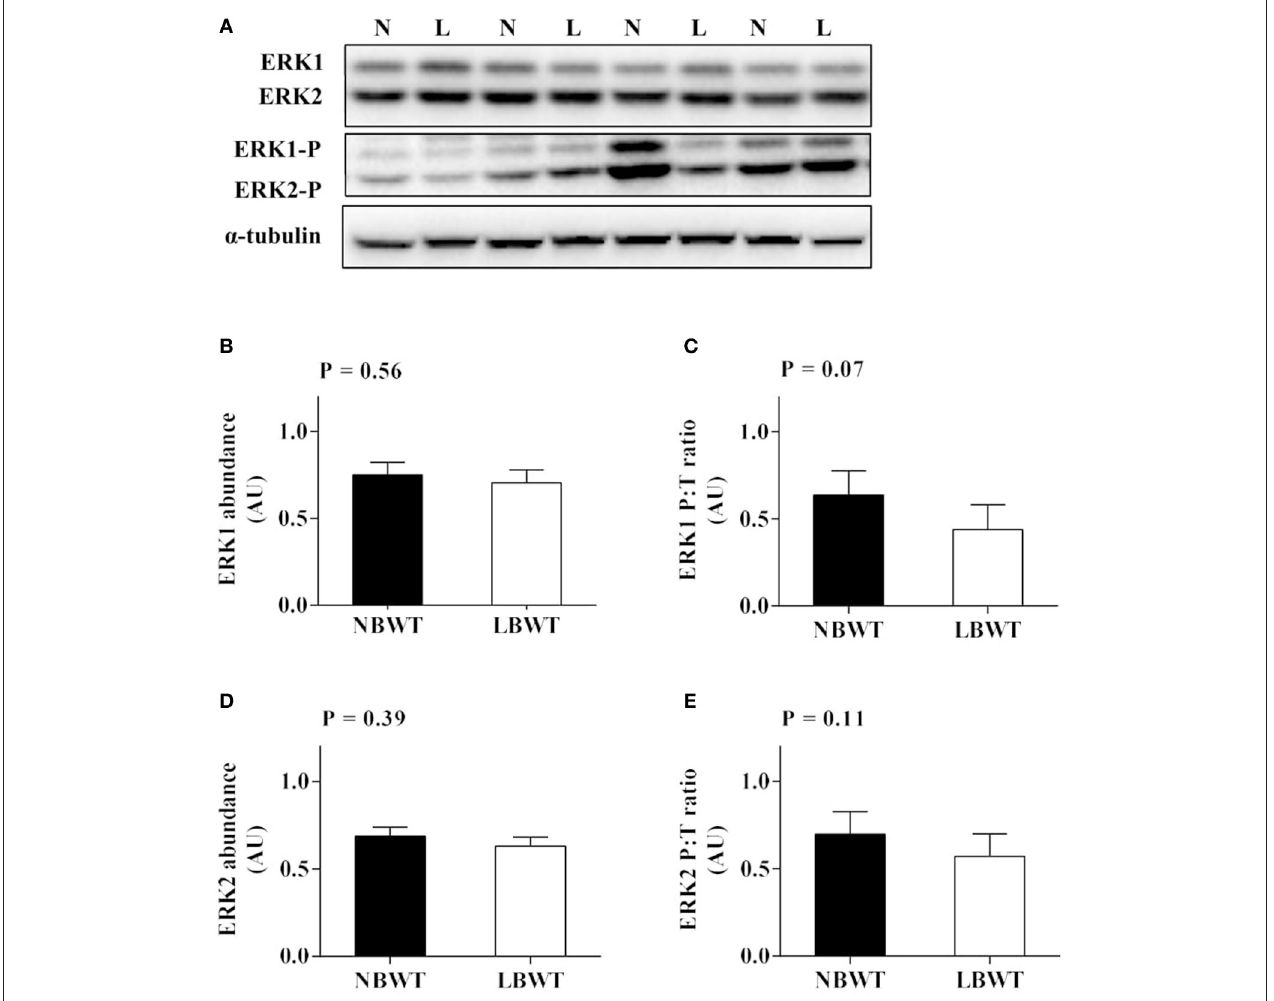
FIGURE 6 | Protein abundance and phosphorylation of ERK1/2 in longissimus dorsi muscle of low-birth-weight (LBWT) and normal-birth-weight (NBWT) neonatal pigs. (A) : Representative western blots from four pairs of LBWT and NBWT pigs (N, NBWT; L, LBWT). (B – E) : Protein abundance and phosphorylation of ERK1 and ERK2. Abundance was normalized to α -tubulin and phosphorylation normalized to the corresponding non-phospho-proteins. Results are means ± SE. n =